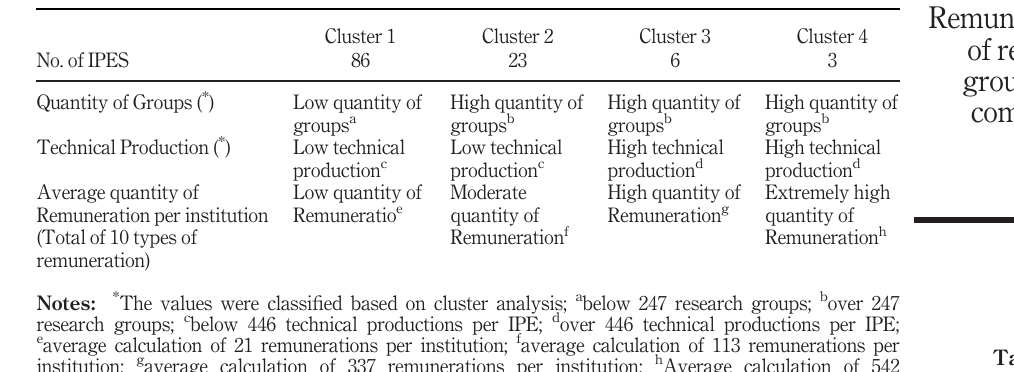
Table VIII. Pro fi le of clusters